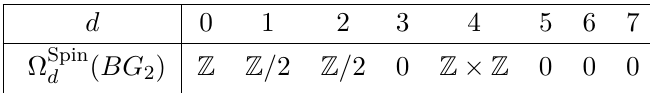
Table 2. Spin bordism groups for BG 2 up to degree 7